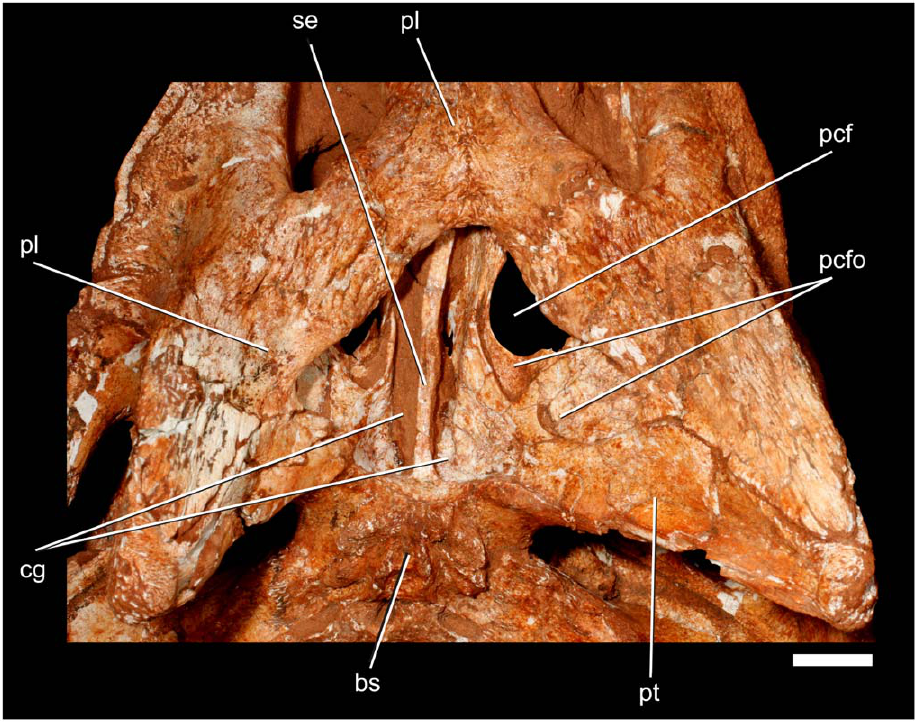
Figure 12. Details of the choanal region of Pissarrachampsasera (LPRP/USP 0019). Scale bar equals 1 cm.